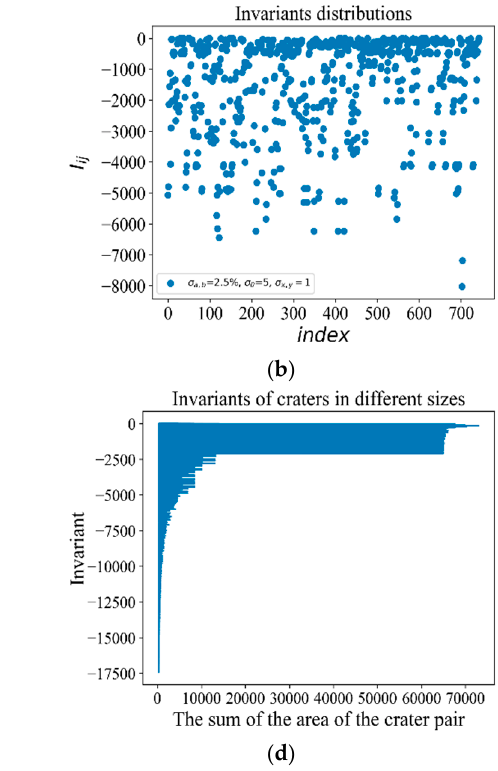
Figure 5. Description of dynamic threshold: ( a ) invariant distribution range ∆ I ij of randomly selected crater pairs, ( b ) invariant I ij of same crater pairs in ( a ), ( c ) where the red line is for factor = 0.3 , and ( d ) invariant distribution of crater pairs of different sizes.